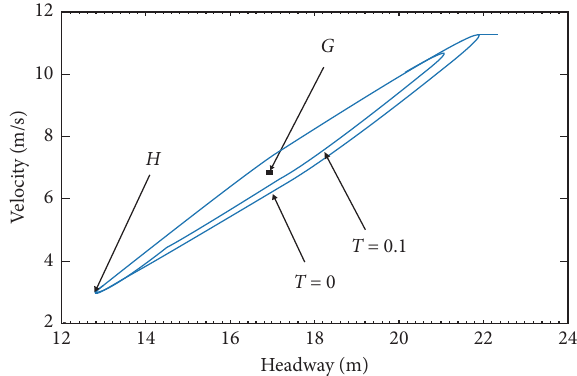
Figure 12: Hysteresis loops for the AAFVD